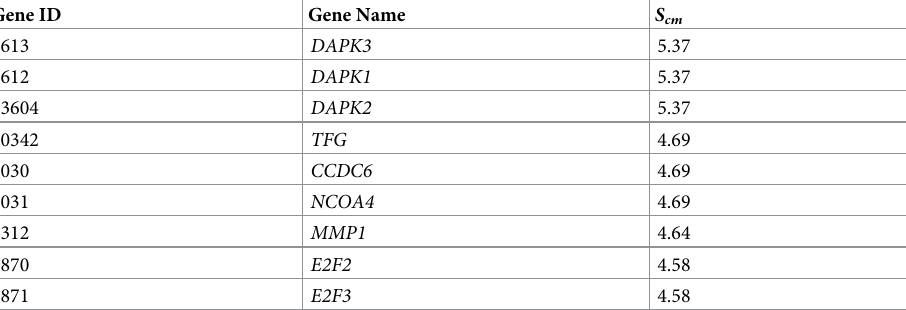
Table 2. Top nine candidates of HCC marker genes selected based on S